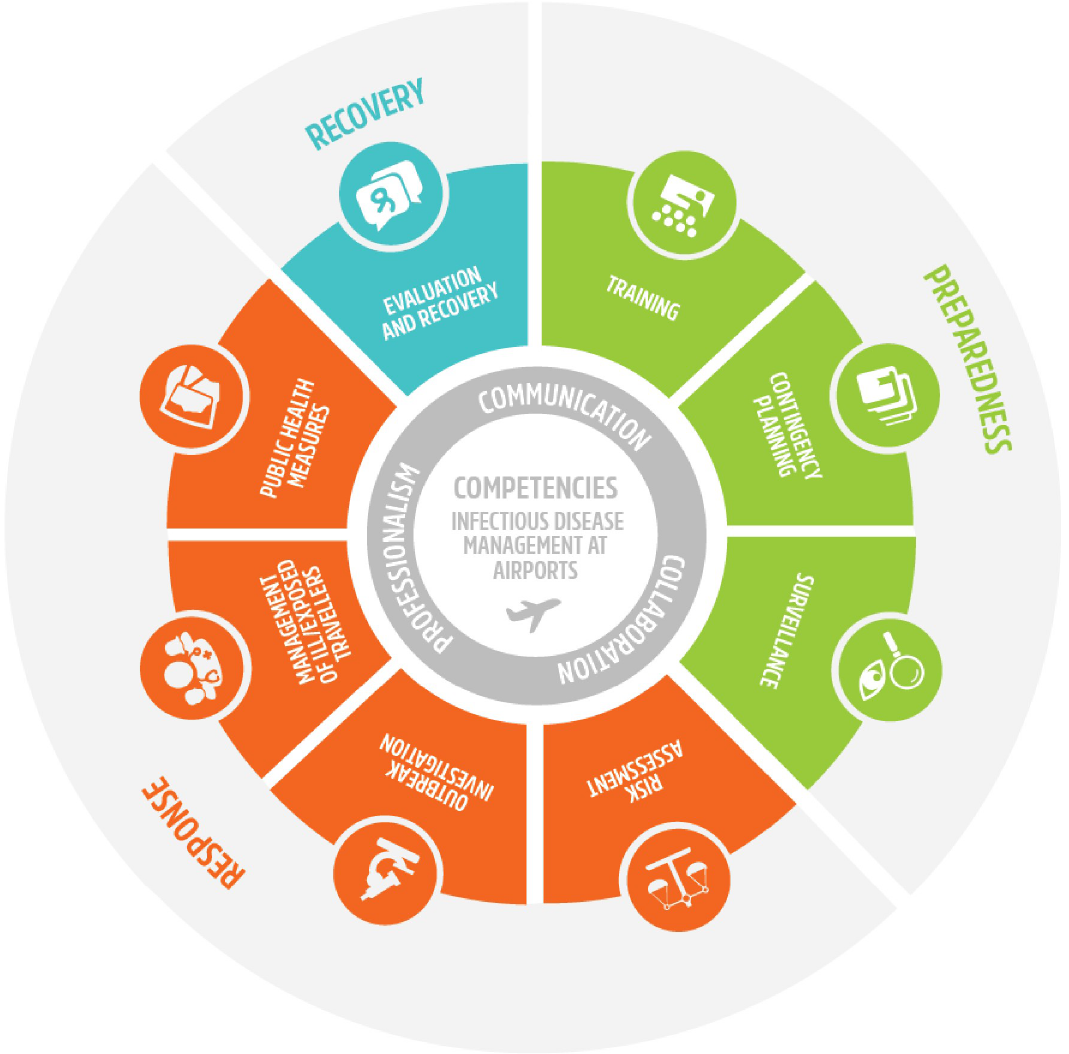
Fig 2. Framework of the competency profile for infectious disease management at airports. Own